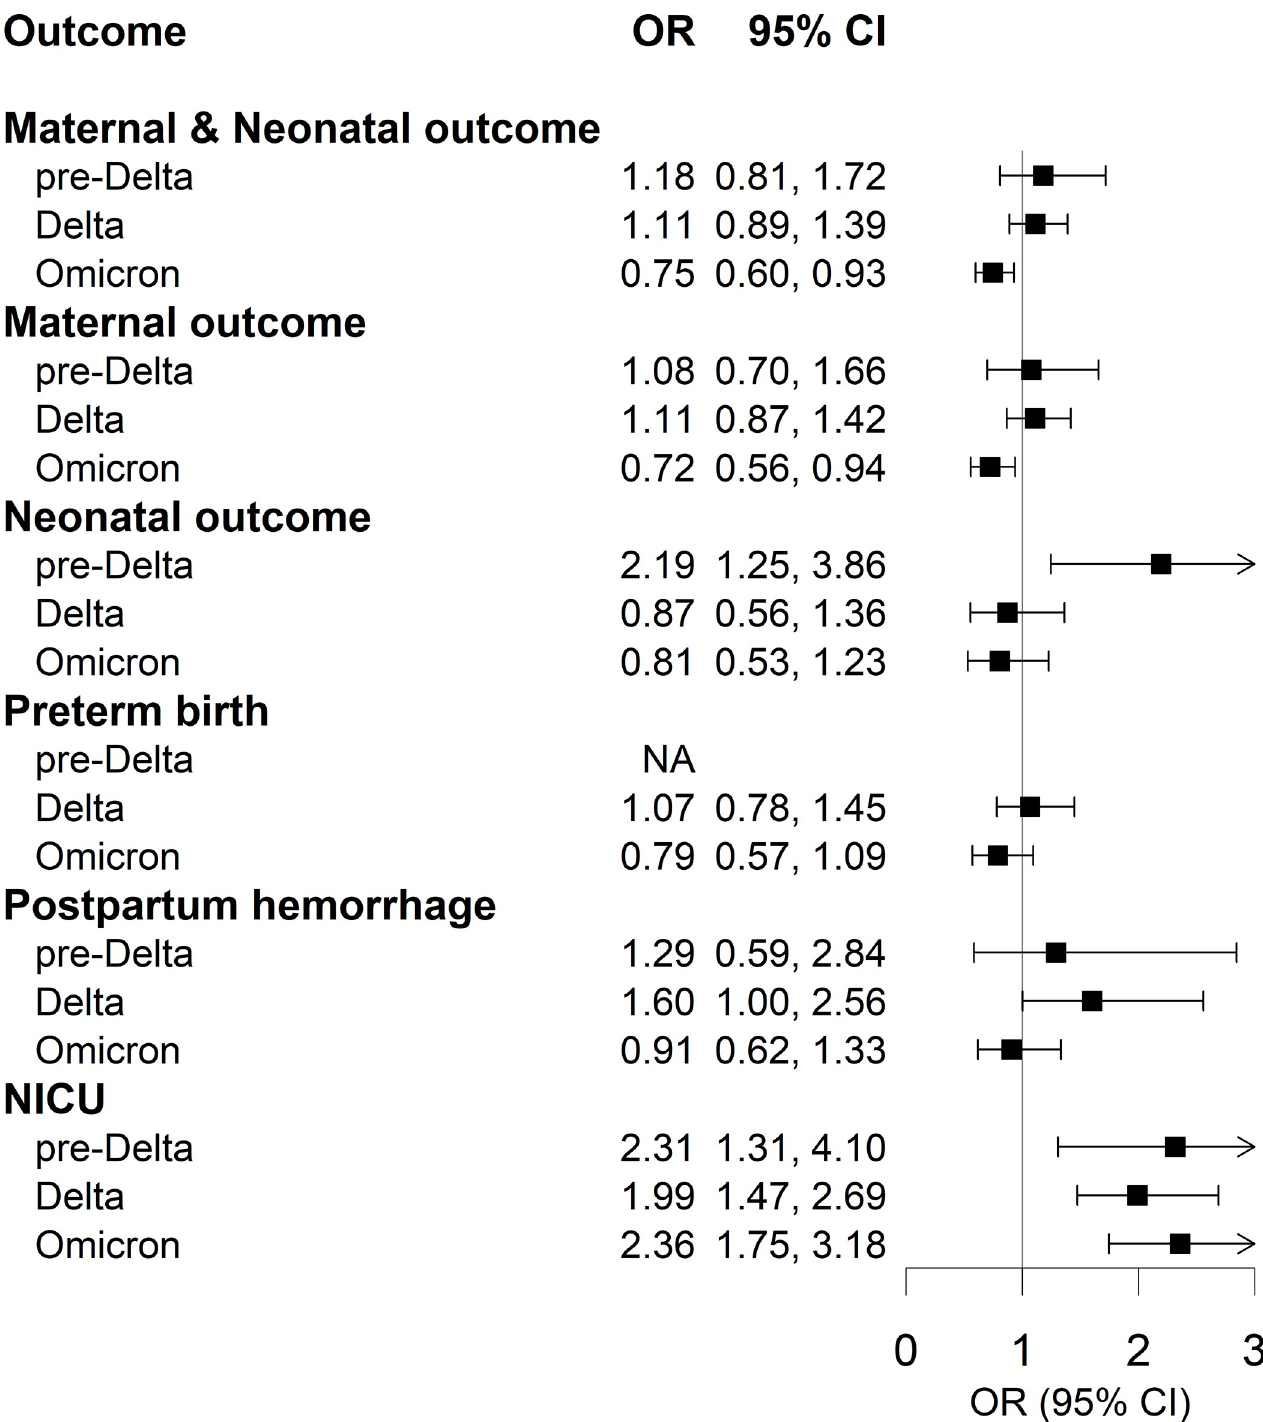
Fig 2. Association of COVID-19 infection during pregnancy with maternal and neonatal adverse outcomes using 1:4 propensity score matching. The arrow indicates when the 95% confidence intervals boundary is beyond the axis limit. In the pre-Delta and Delta periods, the models adjusted for maternal age, sex of child, income, residence area, citizenship, parity, cesarean section, and underlying diseases. The Omicron period, the models adjusted maternal age, sex of child, income, residence area, citizenship, parity, cesarean section, underlying diseases, and vaccination. NA denotes model not applicable. Abbreviations: CI, confidence intervals; OR, odds ratio; NICU: neonatal intensive care unit.